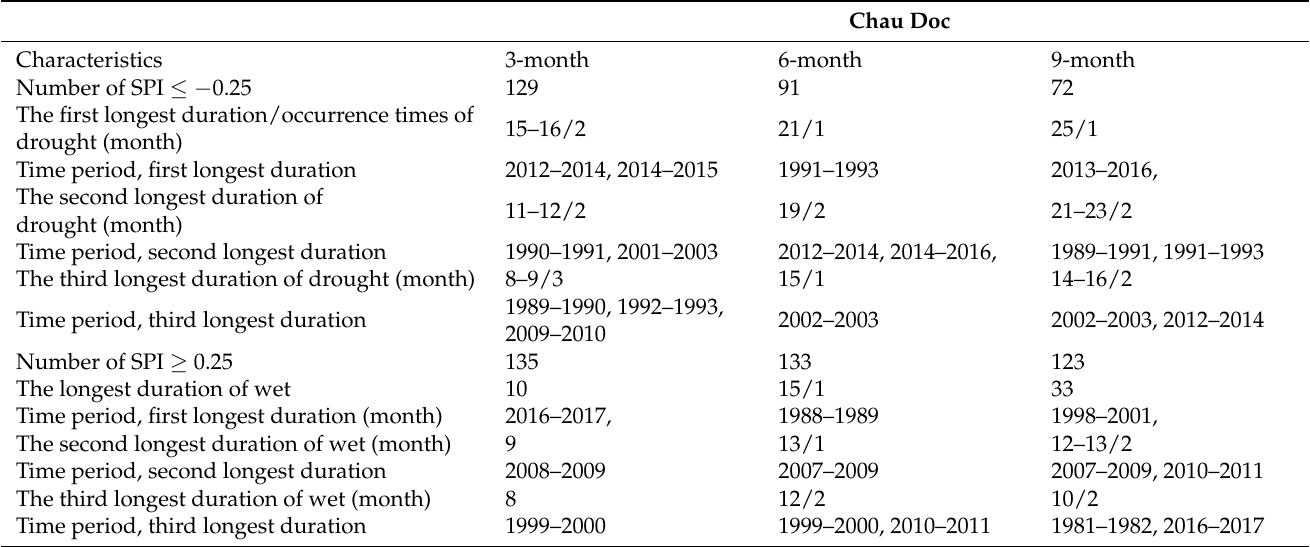
Table 2. SPI values for periods of drought and wet durations in the timeframe of 1980–2019 at Chau Doc meteorological station.